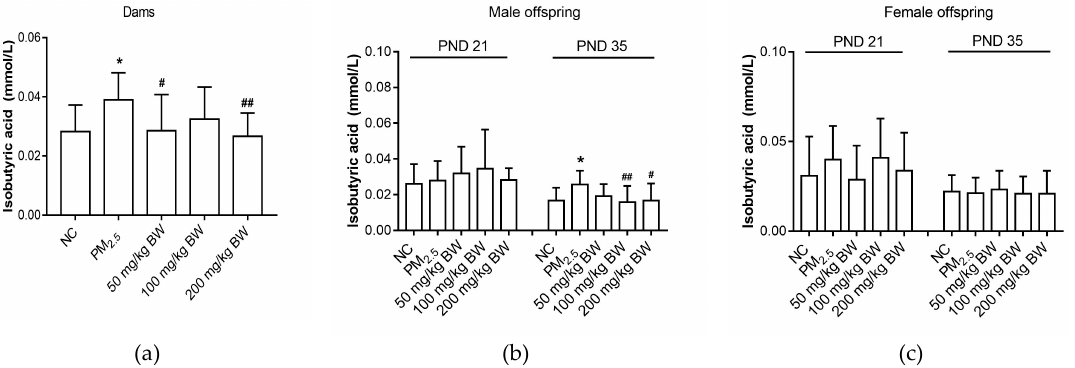
Figure 5. Isobutyric acid concentrations of dams and o ff spring. ( a ) Isobutyric acid of dams on PND 21. ( b ) Isobutyric acid of male o ff spring on PND 21 and PND 35. ( c ) Isobutyric acid of female o ff spring on PND 21 and PND 35. The data was expressed as mean ± SD of each group. Compared with the NC group, * indicates p < 0.05. Compared with the PM 2.5 group, # indicates p < 0.05, ## indicates p <